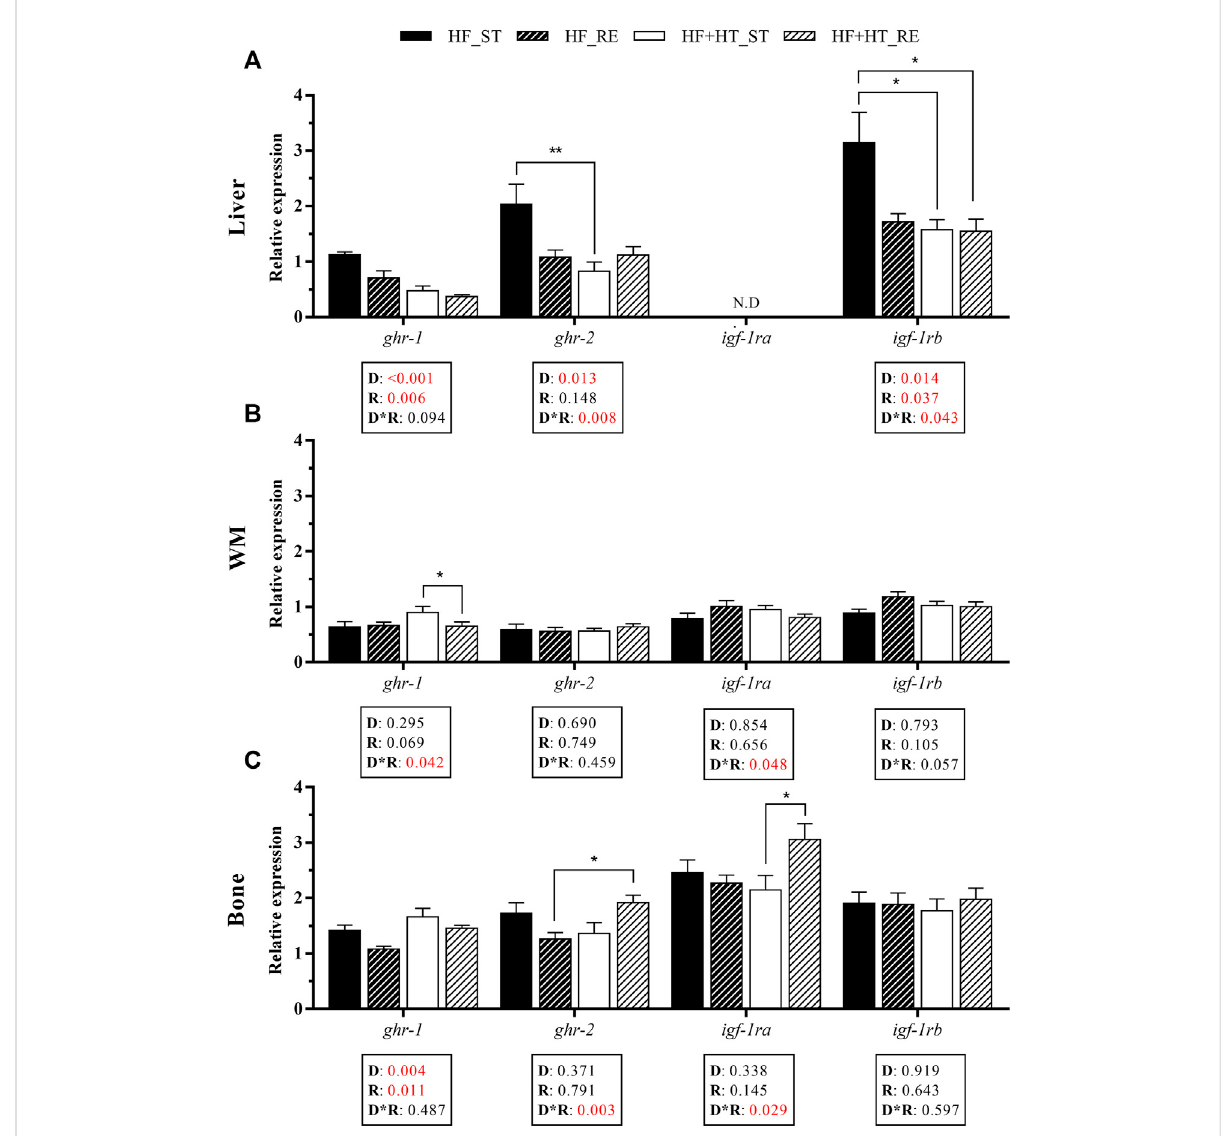
FIGURE 3 Relative gene expression of growth hormone (GH) and insulin-like growth factor (IGF-1) receptors in (A) liver, (B) white muscle (WM) and (C) bone of gilthead sea bream juveniles fed with a high-fat diet in the absence (HF) or presence (HF + HT) of hydroxytyrosol (0.52 g HT/kg feed), at a standard (ST) (3% biomass/tank) or restricted ration (RE) (40% daily reduction) for 8 weeks. Data are shown as Mean + SEM ( n = 10). Statistical differences are indicated in 3 components: diet (D), ration (R) and interaction (D*R), using two-way ANOVA ( p < 0.05, showed in red). When the interaction between the two factors (D*R) was signi fi cant, comparisons among groups were analyzed by a Tukey ’ s post-hoc test and, signi fi cant differences are indicated by asterisks ( p < 0.05 shown as *; p < 0.01 **). N.D.,